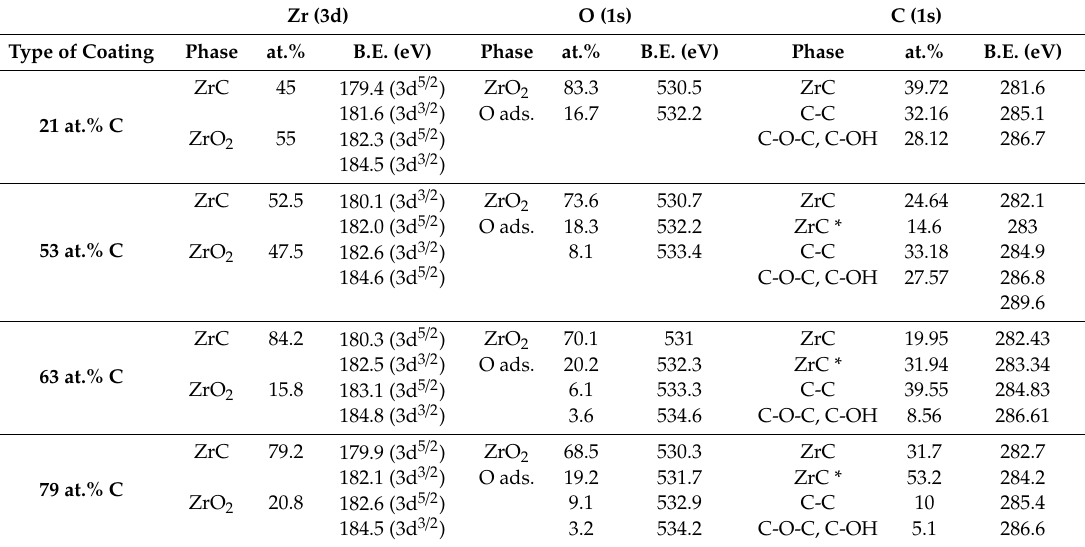
Figure 1. XPS spectra of Zr–C coatings of various carbon concentrations ( a ) Zr 3d, ( b ) O 1s, ( c ) C 1s.